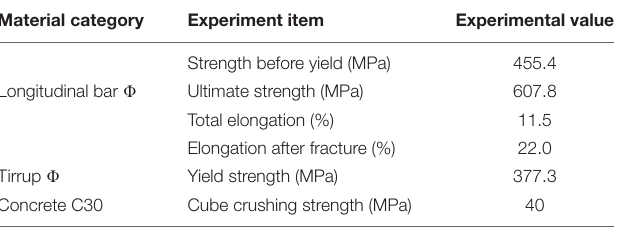
TABLE 1 | Experimental results of material properties.